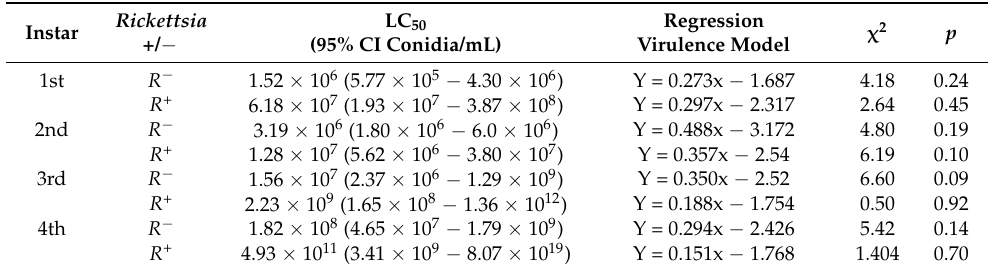
Table 1. Virulence of Akanthomyces attenuatum SCAUDCL53 against different Rickettsia positive and Rickettsia negative developmental stages of B . tabaci .